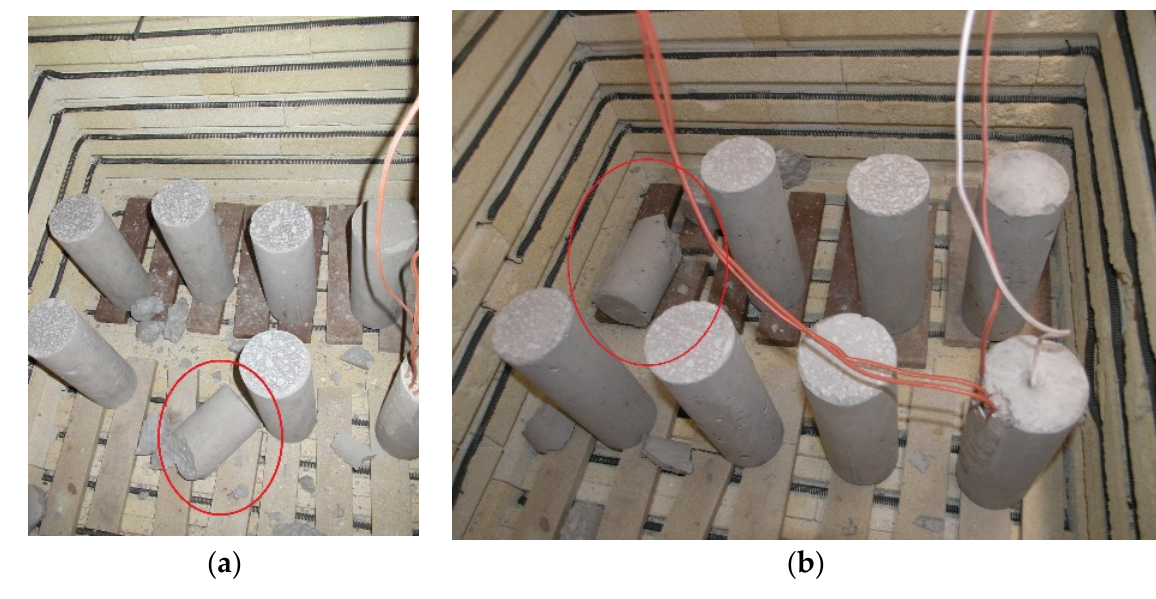
Figure 6. Specimens in the furnace that explosively spalled during heating to ( a ) 400 °C; ( b ) 600 °C.